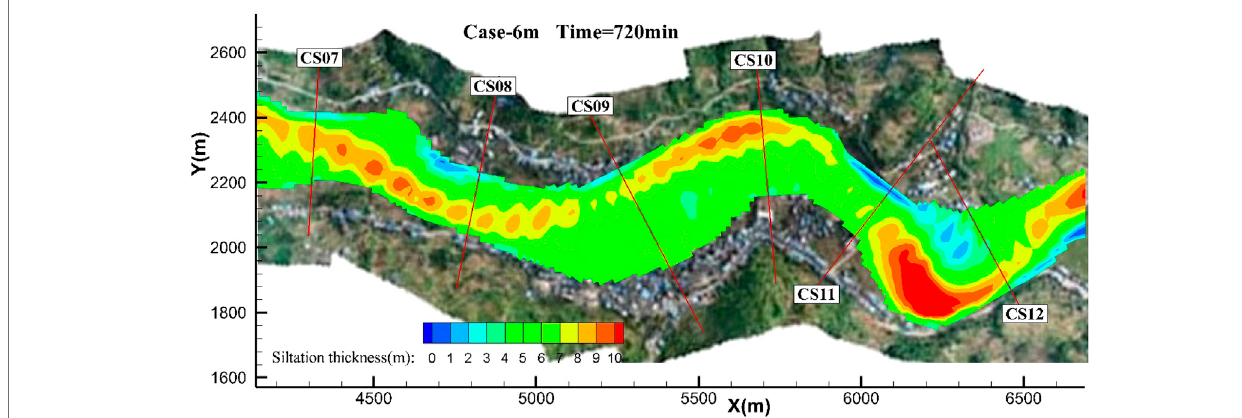
FIGURE 10 | Siltation distribution at Zhongdu Town.